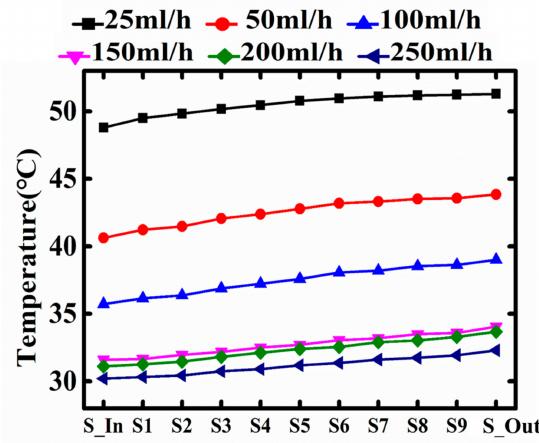
Figure 6. Under different flow rate, the temperature profile in the micro-fluid channel from the inlet to outlet where corresponding the temperature sensors from S-In to